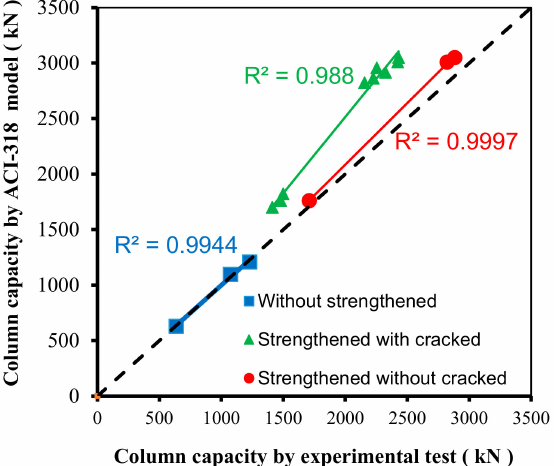
Figure 11. Comparison between the ACI-318 model [43] and the experimental test